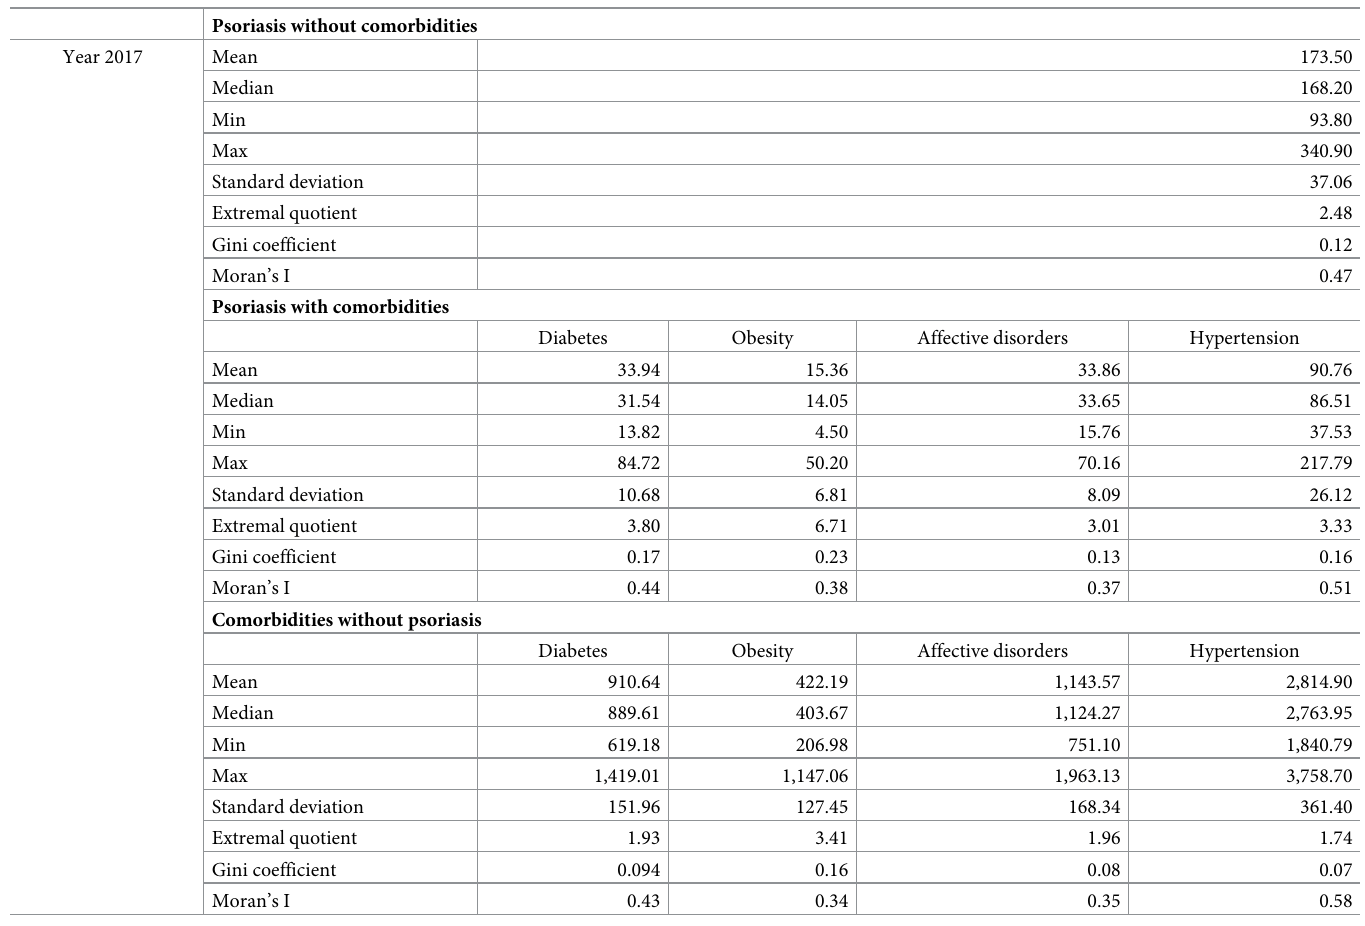
Table 2. Descriptive statistics for comorbidities with and without psoriasis for 2017 (patients per 10,000 statutory health insured people). Psoriasis without